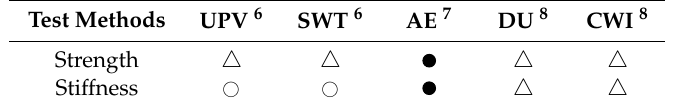
Table 3. Evaluation of regain in mechanical properties due to